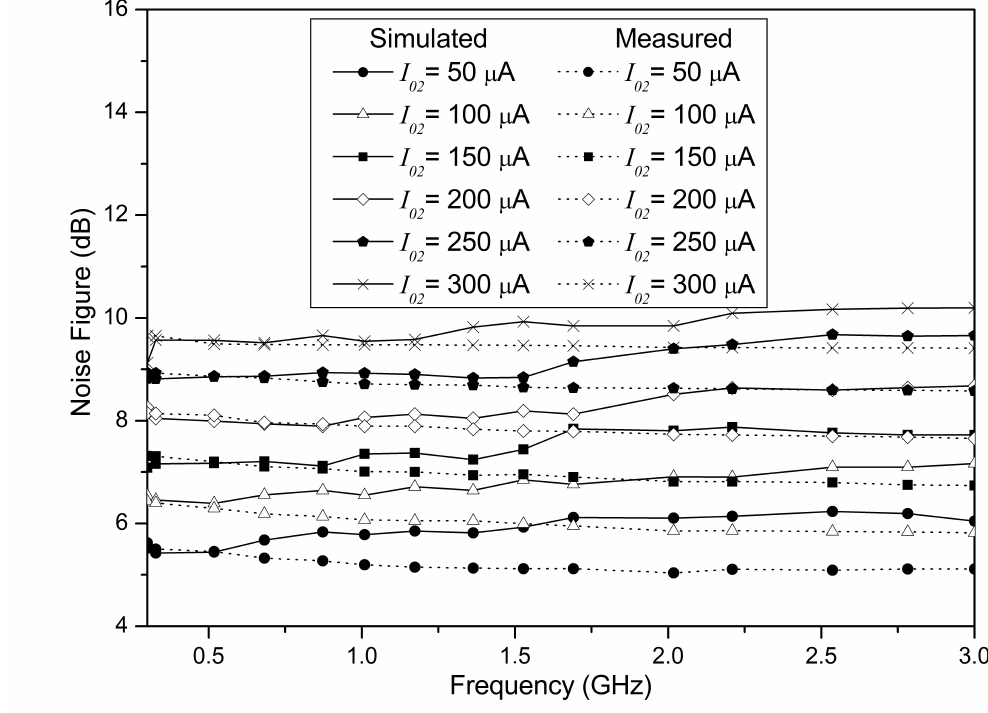
Figure 11. Measured and simulated NF of the RF-VGA for different bias currents I 02